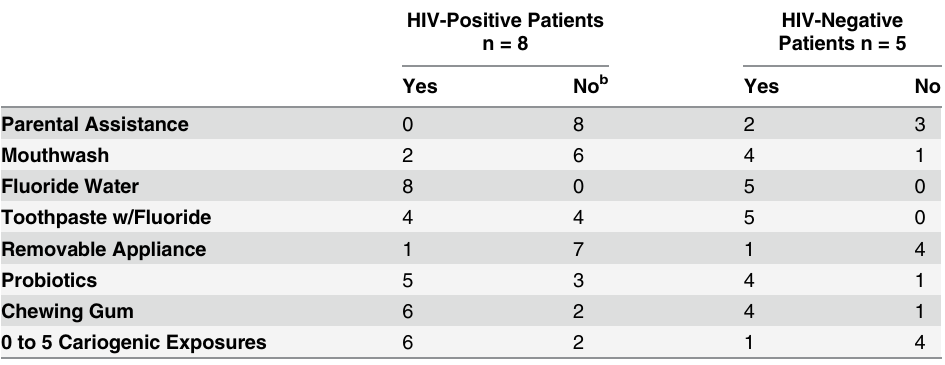
Table 2. Dental Characteristics a .